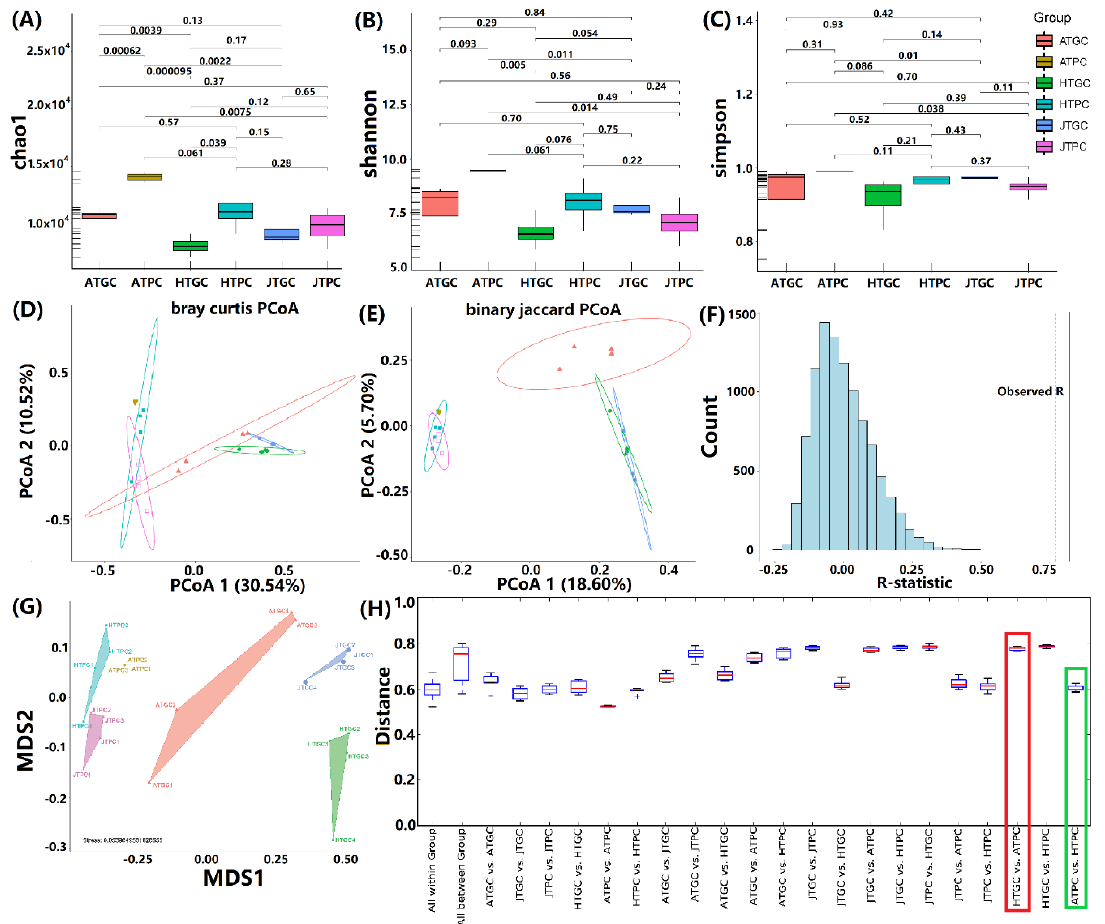
Figure 1. Alpha- and beta-diversity, analysis of similarities (ANOSIM) group similarity, NDMS, and group distance analyses of different growth stages of freshwater turtle C. reevesii in six groups. ( A ): Chao1, ( B ): Shannon, ( C ): Simpson, ( D ): Bray–Curtis, ( E ): binary Jaccard, ( F ): ANOSIM group similarity, ( G ): NDMS analysis, ( H ): group distance. The red boxes represent the maximum group distances and the green boxes represent the minimum group distances.